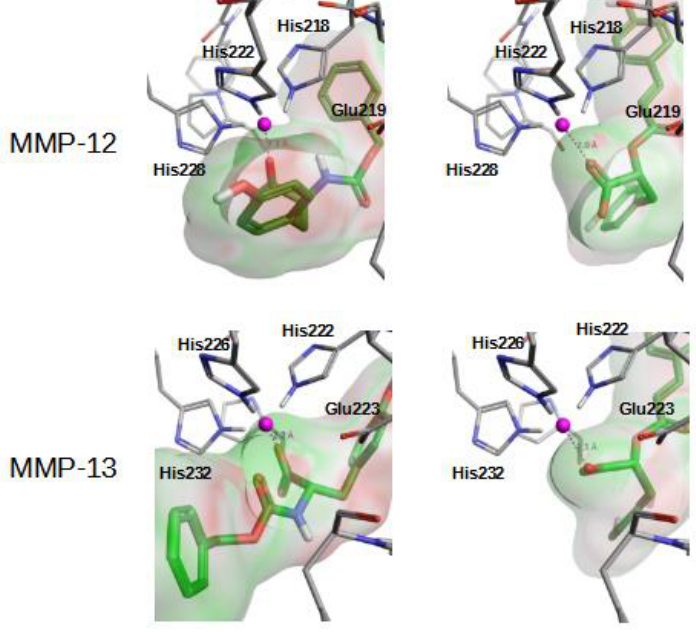
Figure 5. Best docking poses for natural compounds 2169918 and 19878945 at the Zn 2+ binding site of MMP-8, MMP-9, MMP-12 and